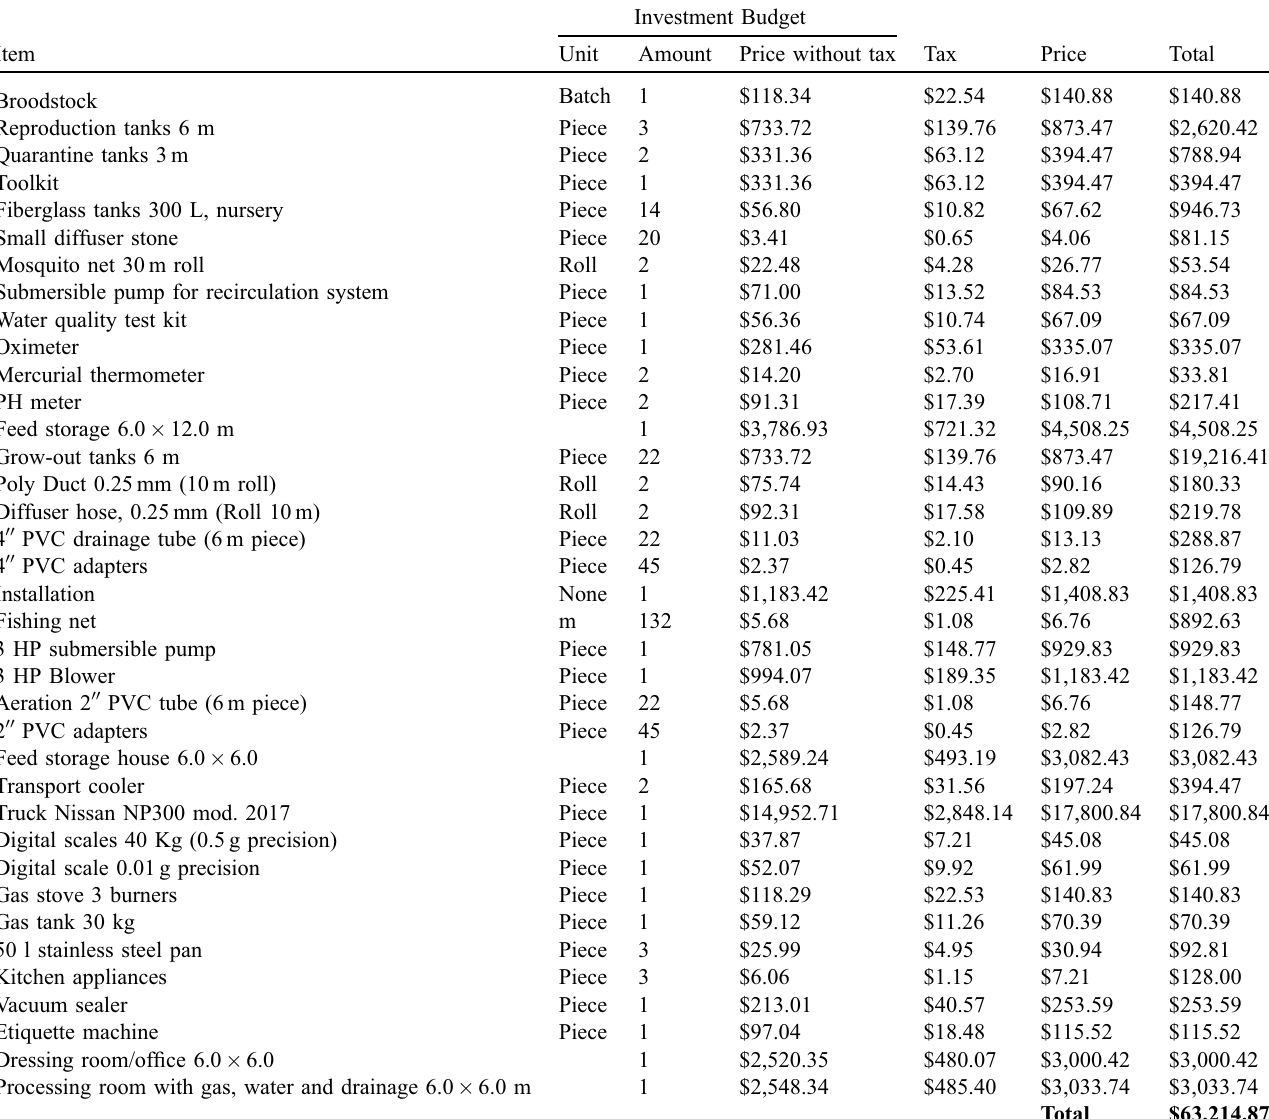
Table 2. Investment Budget (based on costs for